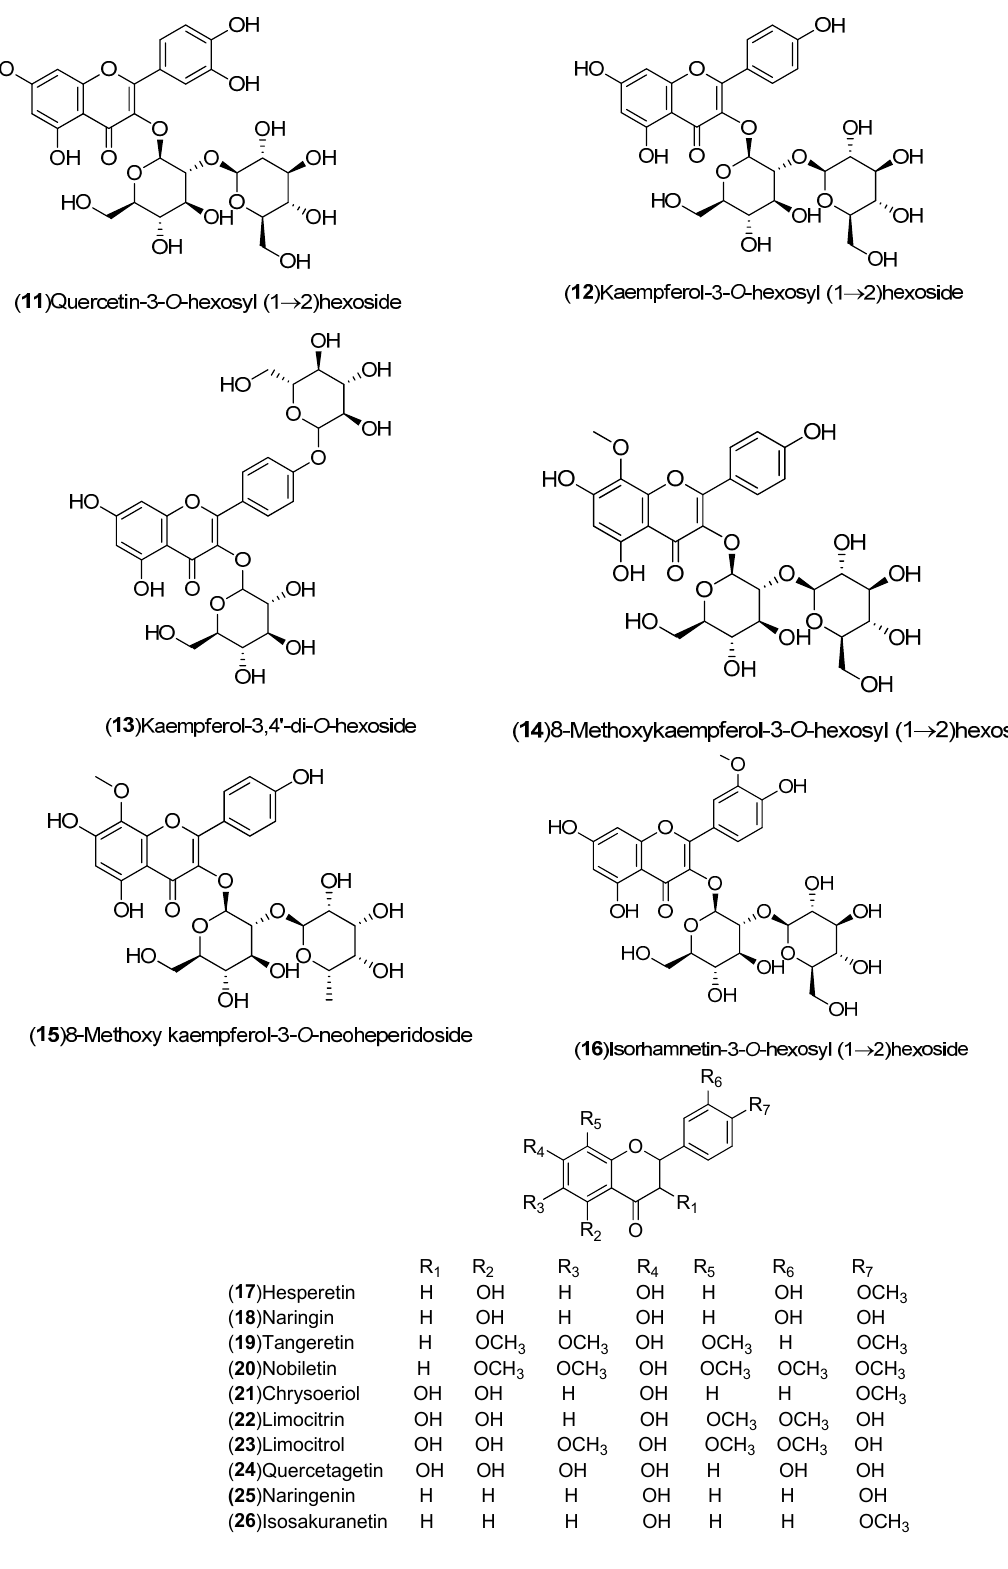
Figure 1. Figure 1. Cont.